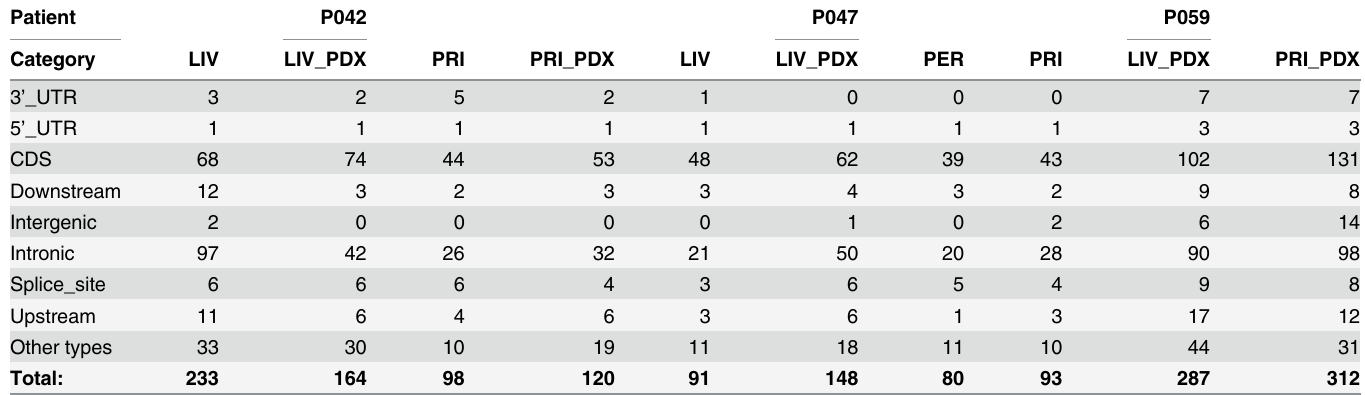
Table 2. Summary of locations of somatic SNVs.